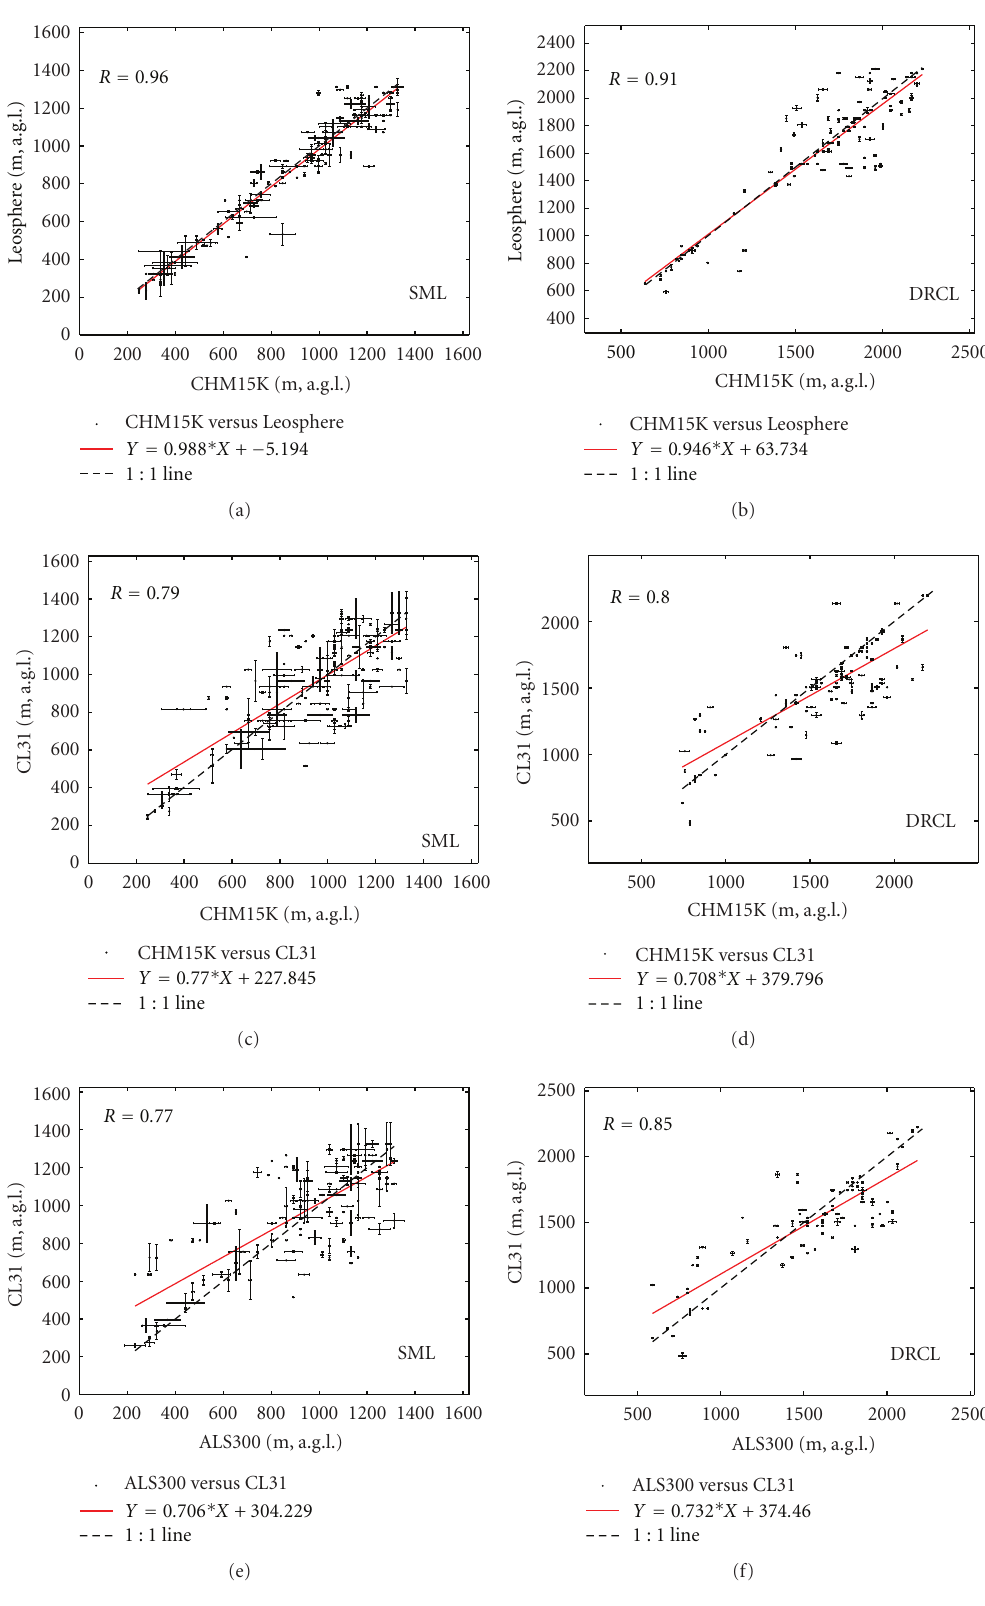
Figure 4: Linear correlation of SML and DRCL detections on the 15th of June, 2009. (a, b) show the ALS300-CHM15K comparison; (c, d) show CL31-CHM15K; (e, f) show CL31-ALS300. A filter has been applied for outliers > 2 σ stdv . Error bars have amplitude 2 σ THT